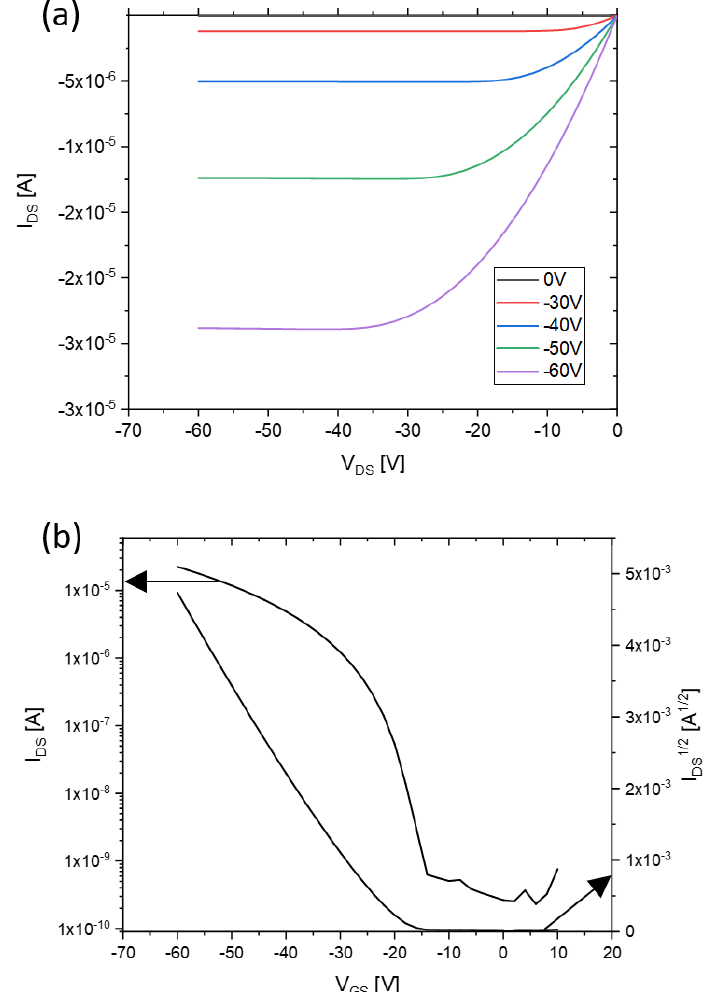
Figure 8. The ( a ) transfer and ( b ) output current–voltage characteristics of OFET fabricated with usage of source and drain golden electrodes, obtained by vacuum evaporation of gold through shadow mask. The OFET channel length of OFET was 250 µm and electrode configuration was bottom gate–top contact.